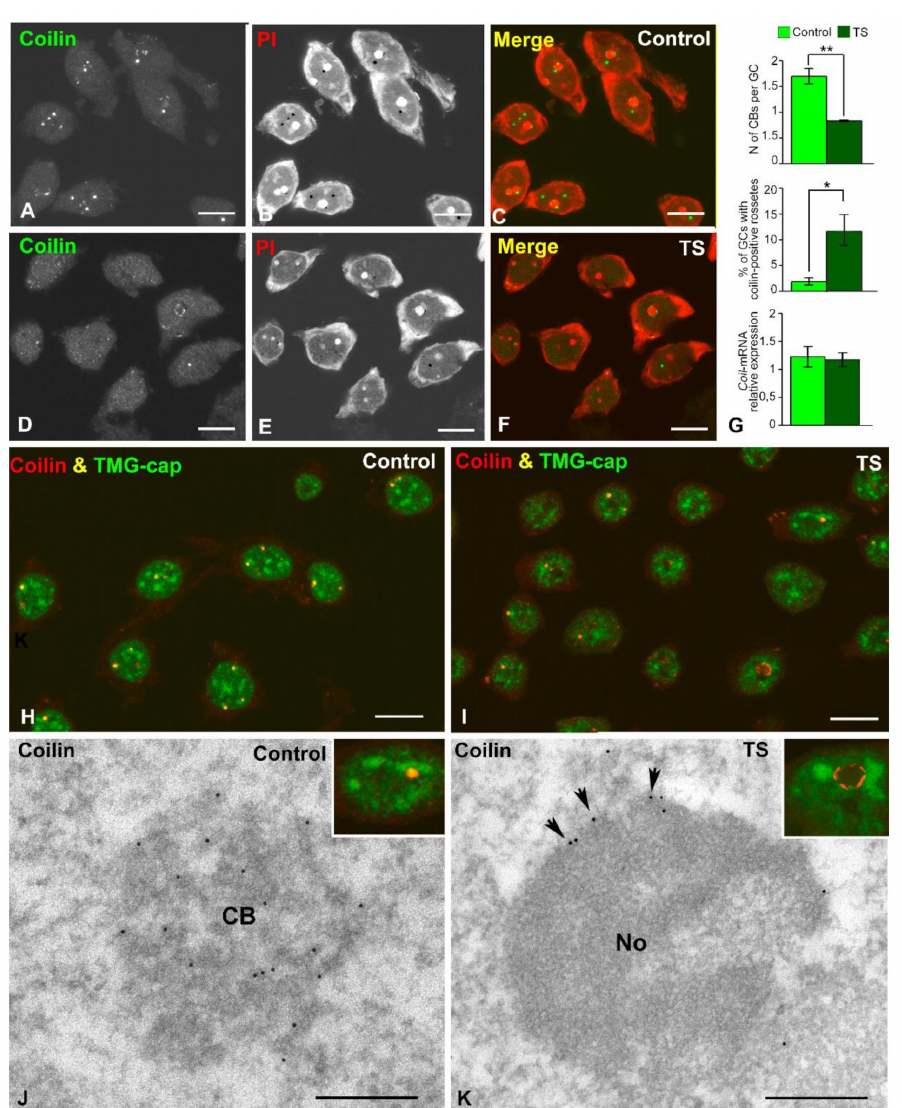
Figure 5. The GCs of TS mice present reduced CB number and coilin redistribution. ( A – F ) Co- staining for coilin, for demonstration of CBs, and PI, for the RNA-rich structures, in dissociated GCs from control ( A – C ), and TS ( D – F ) mice. Note the apparent reduction of CBs in TS GCs relative to control ones. Scale bars: 5 µ m. ( G ) Quantitative analysis of the mean number of CBs per GC and the proportion of GCs containing coilin-positive perinuclear caps (“rossetes”). TS GCs exhibit a significant reduction of CBs and a significant parallel increase of perinuclear “rossetes”. This nuclear reorganization of coilin in TS GCs was not associated with significant changes in the expression level of the Coil gene. Data is presented as means + SEM of three independent experiments. ( H , I ) Double immunolabeling for coilin and TMG-cap (a marker of spliceosomal U snRNAs) reveals the typical colocalization of coilin and splicing factors in CBs and the absence of any detectable TMG-cap signal in the coilin-positive perinucleolar caps. Scale bars: 5 µ m. ( J , K ) Immunogold electron microscopy for the detection of coilin in typical CBs ( J , scale bar: 250 nm) and a perinucleolar cap (arrow heads in panel K , scale bar: 500 nm). Insets illustrate the confocal microscopy counterpart of a double immunofluorescence for coilin and TMG-cap in GC nuclei. *: p < 0.05, **: p < 0.01. C = control mice; CB = Cajal body; No = nucleolus; PI = propidium iodide; TS = Ts65Dn mice. Next, to determine the presence of spliceosomal snRNPs in CBs we performed double immunolabeling for TMG-cap, which recognizes the 5 (cid:48) cap of spliceosomal snRNAs, and coilin. Whereas both molecular constituents colocalized in typical CBs from both control